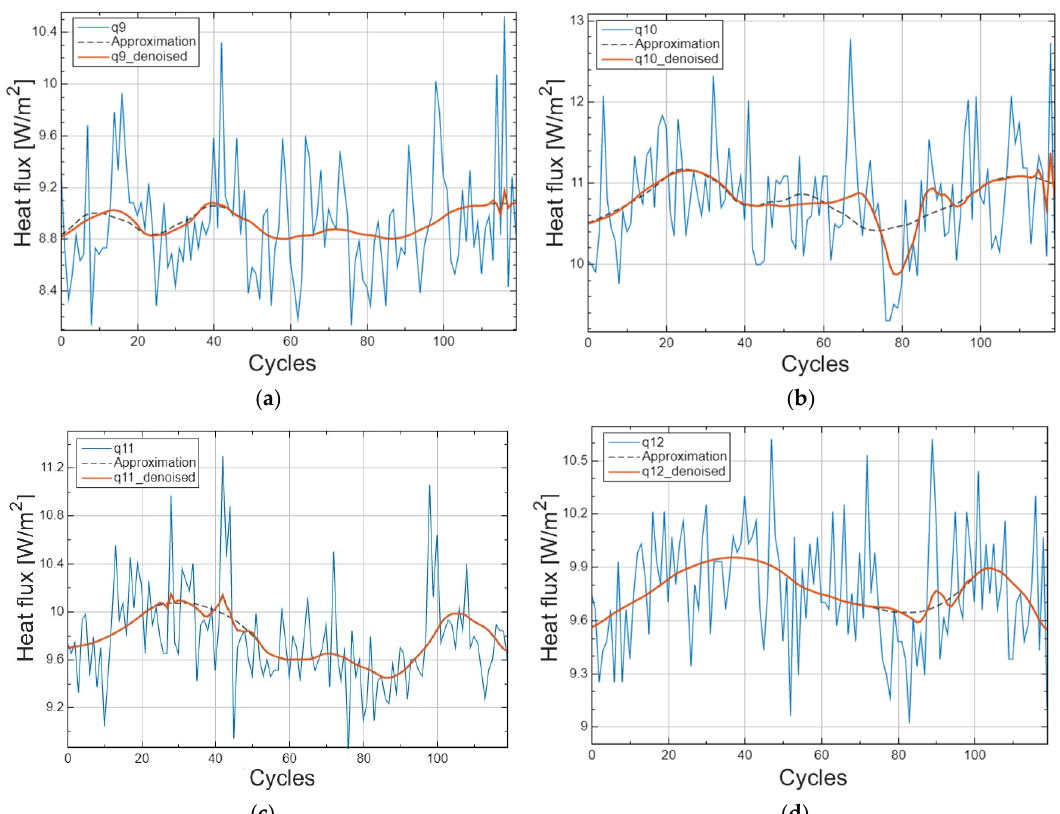
Figure 9. Denoising of heat flux sensor signals using the Daubechies 4 wavelet at decomposition level 4 for ( a ) q 9 , ( b ) q 10 , ( c ) q 11 , and ( d ) q 12 . In Figure 9, the following are marked as follows: red colour—denoised signal, blue— heat flux waveform, and dashed line—approximation a 4 . In addition, a statistical analysis of the denoised signals was carried out, the results of which are presented in Table 3. In Table 4, the average values of the heat flux and temperature for both approaches of pro ‐ cessing measurement data are given. Table 3. Standard deviation values for signals of heat flux sensors.